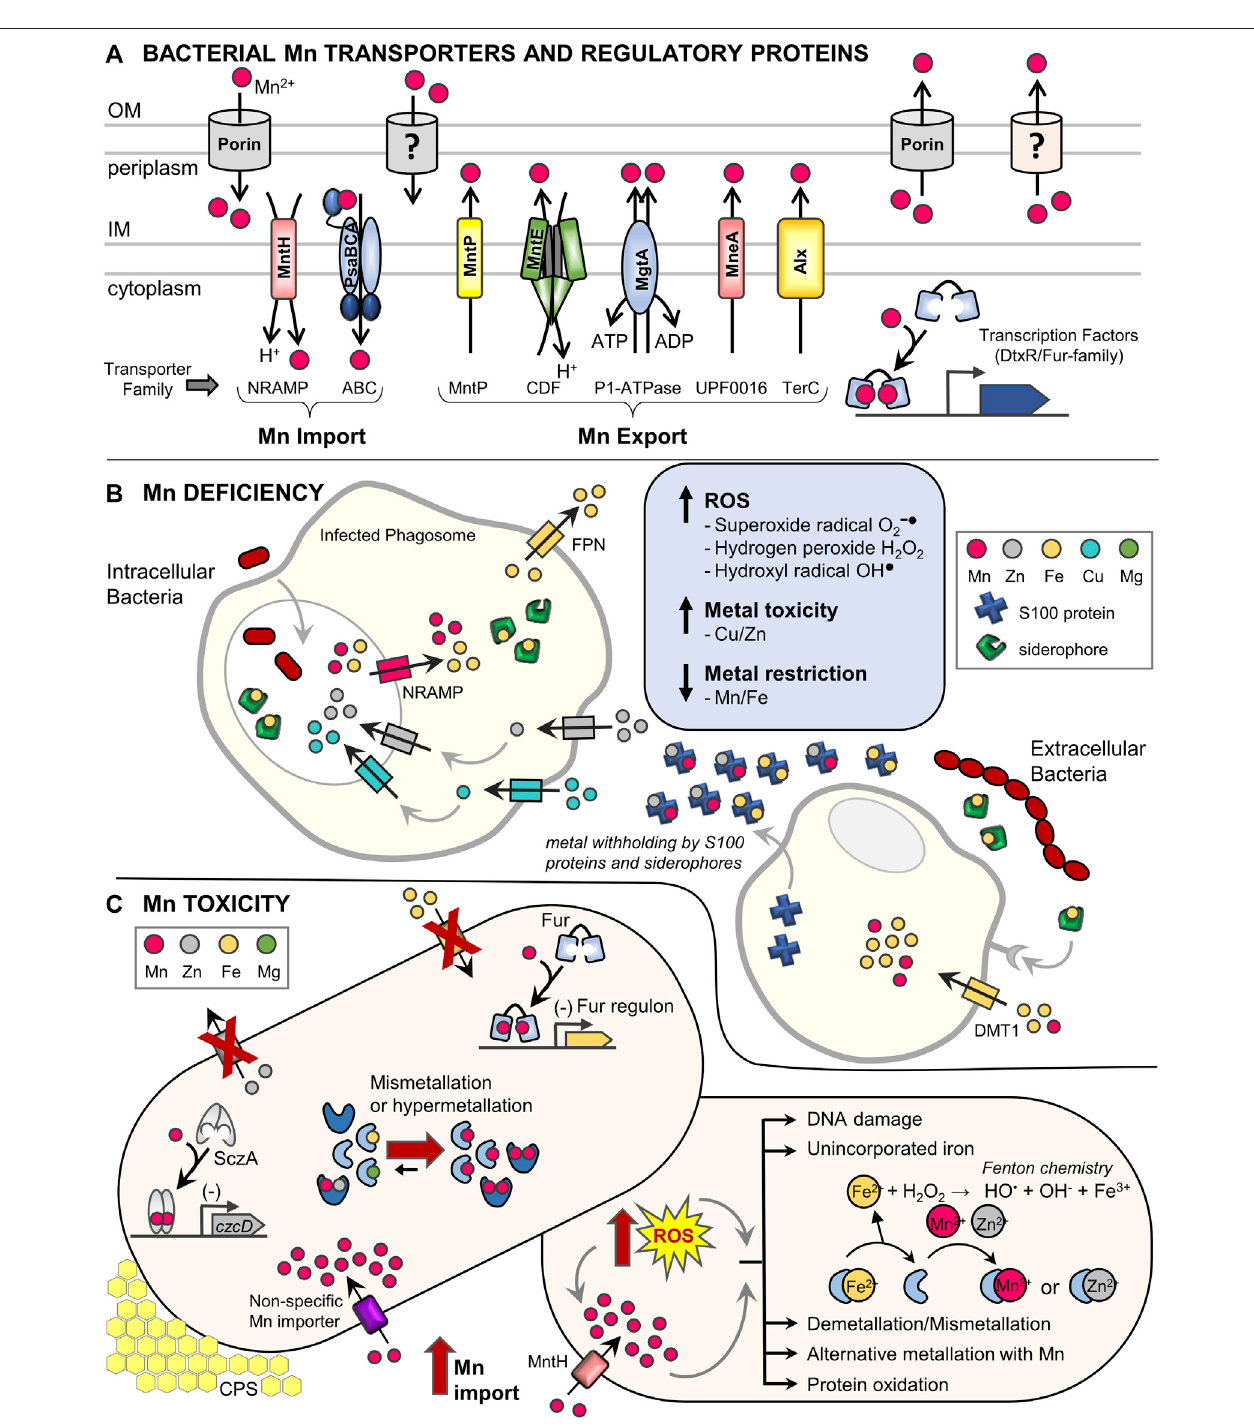
FIGURE 1 | Dedicated manganese protein homeostasis machinery and impact of host defenses during bacterial pathogenesis. (A) Characterized bacterial Mn transporters and regulatory proteins. The bacterial Mn homeostasis protein machinery consists of dedicated, high-af fi nity Mn importers, exporters, and metal-binding transcriptionfactors. Mostbacteria containatleastoneofeithertheNRAMP(MntH) orABCtransporter(PsaBCA)familyimportersintheinner membrane (IM), aswellas one or more Mn-speci fi c exporter types including the MntP, CDF, P1-type ATPase, UPF0016, and TerC families (Waters, 2020; Bosma et al., 2021). The distributionofMnimportersandexportersacrossbacterialspeciesiscomplexandnotfullyunderstood(Zeinertetal.,2018).ExpressionofMntransportersiscommonly controlled by Mn-sensing transcription factors ofthe DtxR (MntR) or Fur (Mur) families (Capdevila et al., 2017). Post-transcriptional expression ofseveral Mn exportersis alsoregulatedbyaMn-sensingriboswitch,whileothersareconstitutivelyexpressed(Waters,2020).Additionaloutermembrane(OM)componentsmayalsobeinvolved